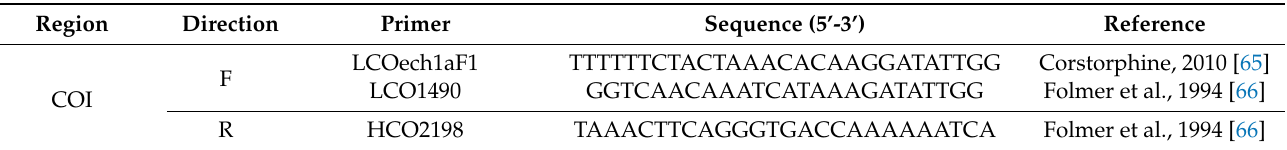
Table 2. List of used primers for cytochrome oxidase I (COI) amplification in our work. Forward primers (F) and reverse primer